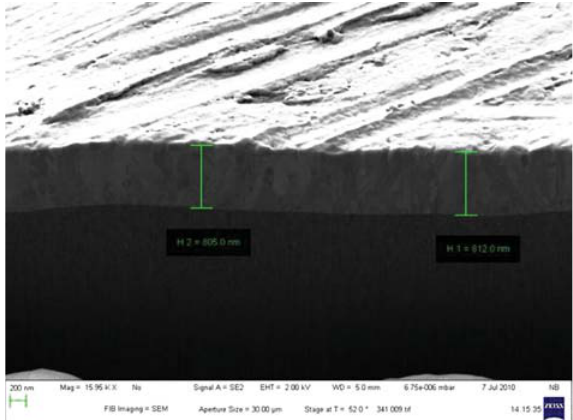
Figure 17: Smooth surface (lifetime: 55,000 cycles).